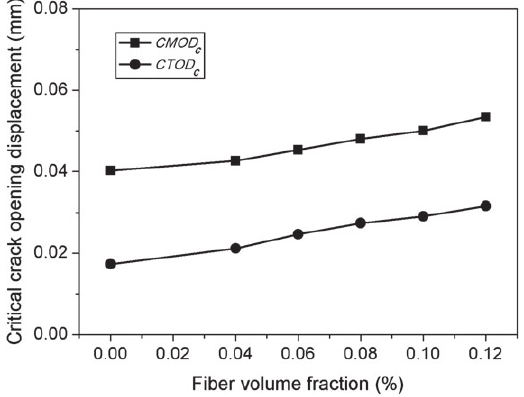
Figure 9 Effect of the polypropylene fiber on the CMOD